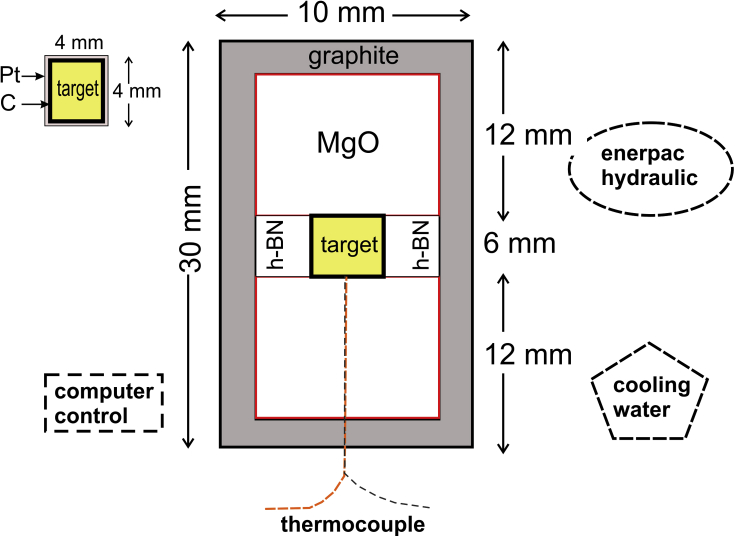
Geometric apparatus for the experiments. Modified and adapted after [1].